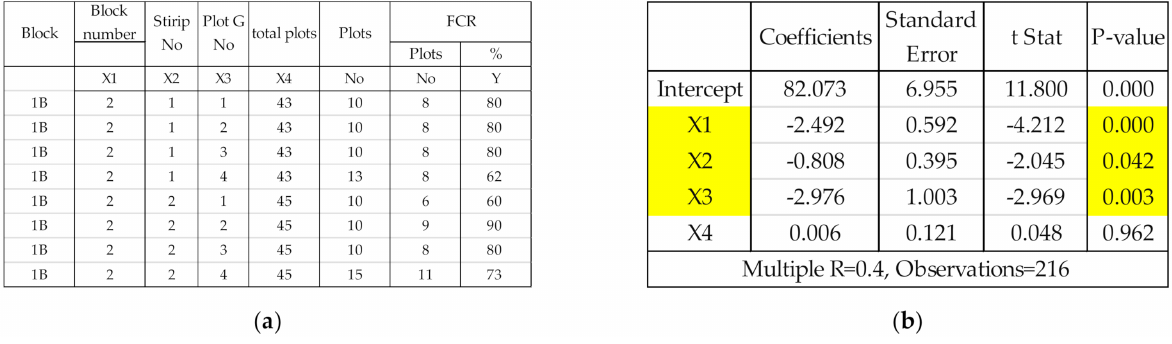
Figure 8. Sample of regression parameter ( a ) and inter strip multi regression results at 95% signifi- cance ( b